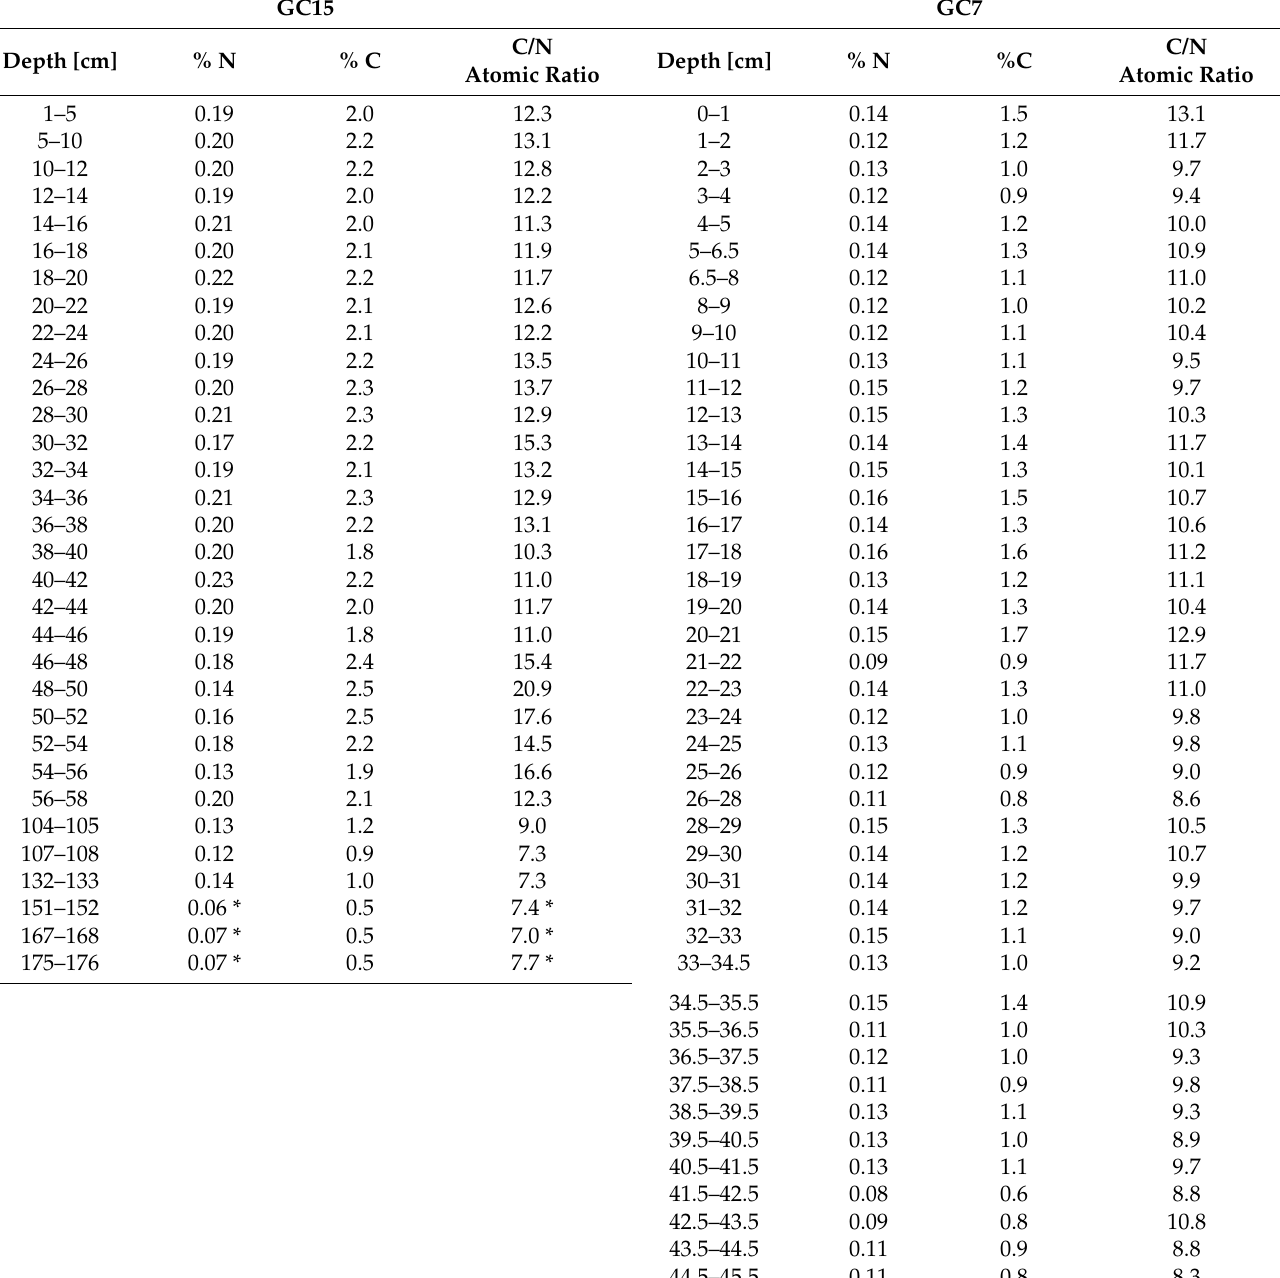
Table A3. Carbon and nitrogen contents and C/N atomic ratio in the GC15 and GC7